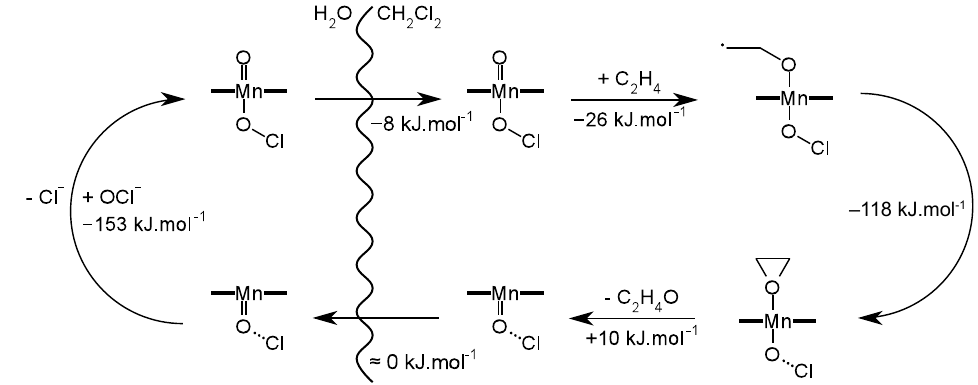
Figure 5. Catalytic cycle of Mn(acacen)ClO in a biphasic water/dichloromethane medium, adapted from Cavallo and Jacobsen [48]. The structure of the acacen moiety is represented in a simplified fashion, using black bars around the manganese